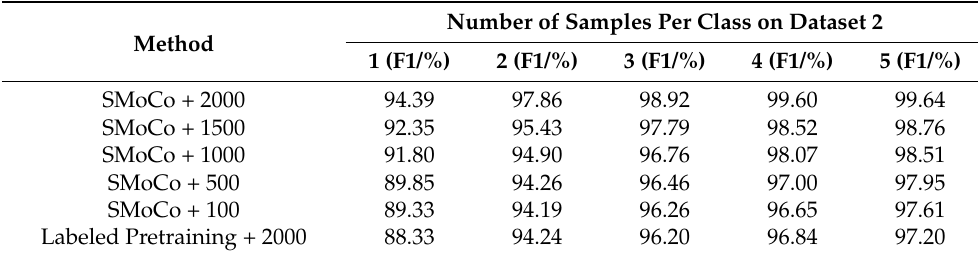
Table 8. Experimental results of the sensitivity to the size of the data set on dataset 2.